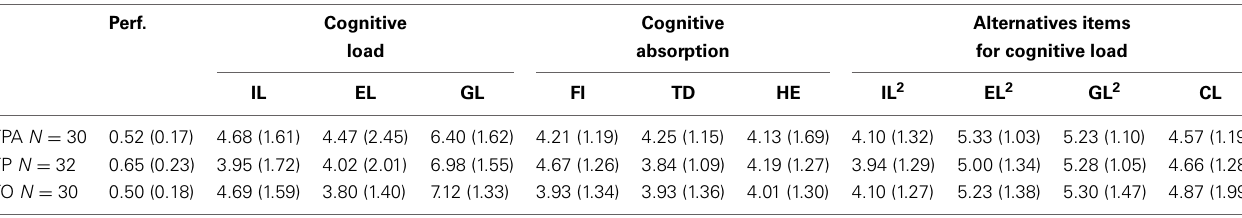
Table 1 | Means ( SD ) of the main dependent variables in the first phase.